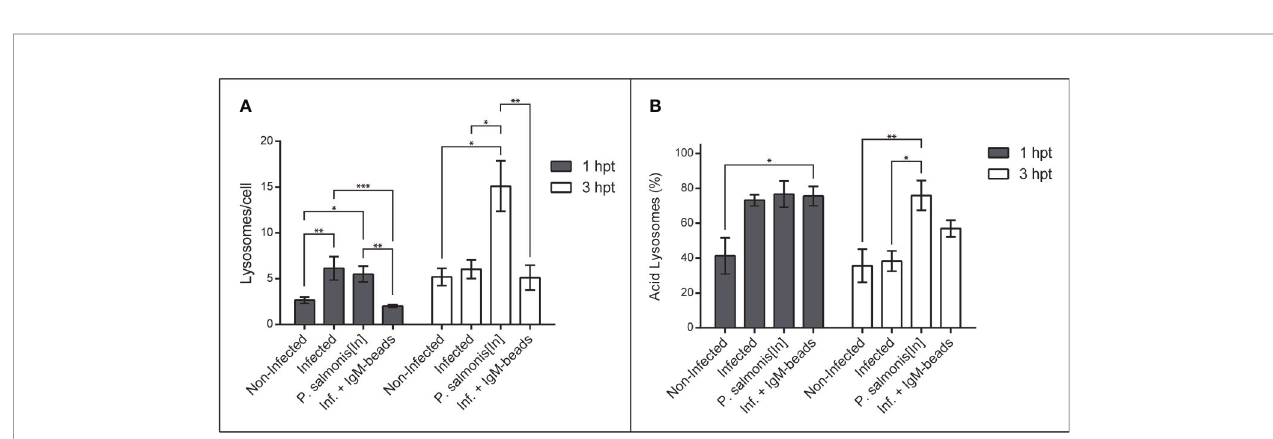
FIGURE 2 | Lysosomal quanti fi cation in infected macrophage-enriched cell cultures treated with IgM-beads. Macrophage-enriched cell cultures were infected with P. salmonis at a MOI of 10 bacteria/cell and analyzed at 1 and 3 hpt. The lysosomes were stained with the LSYB probe and quanti fi ed as acidic lysosomes or neutral-basic (NB) lysosomes. The data were normalized to the number of cells analyzed. (A) Total number of lysosomes per cell. (B) Percentage of acidic lysosomes for each condition. The statistical analysis was performed through parametric ANOVA with a Tukey multiple comparison test. Signi fi cant differences: *p < 0.05, **p < 0.01, ***p <